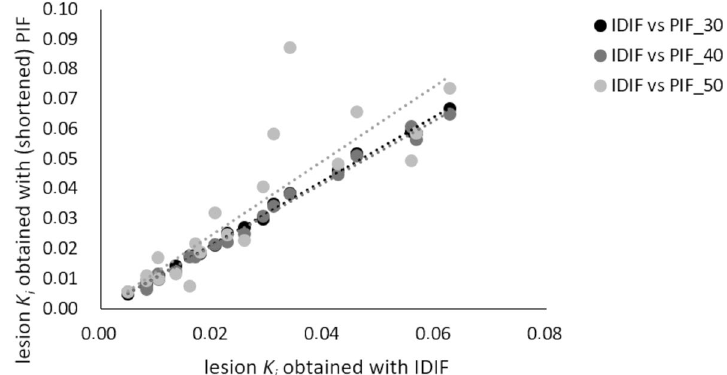
Fig. 3 Scatter plots of lesion K i obtained using the IDIF versus lesion K i obtained using the PIF scaled to the IDIF at 30–60 min p.i. (PIF _30) and the PIF scaled to the IDIF at shortened scan time intervals p.i. (PIF _40 and PIF _50). Dashed lines represent linear regression fits (with intercept set to